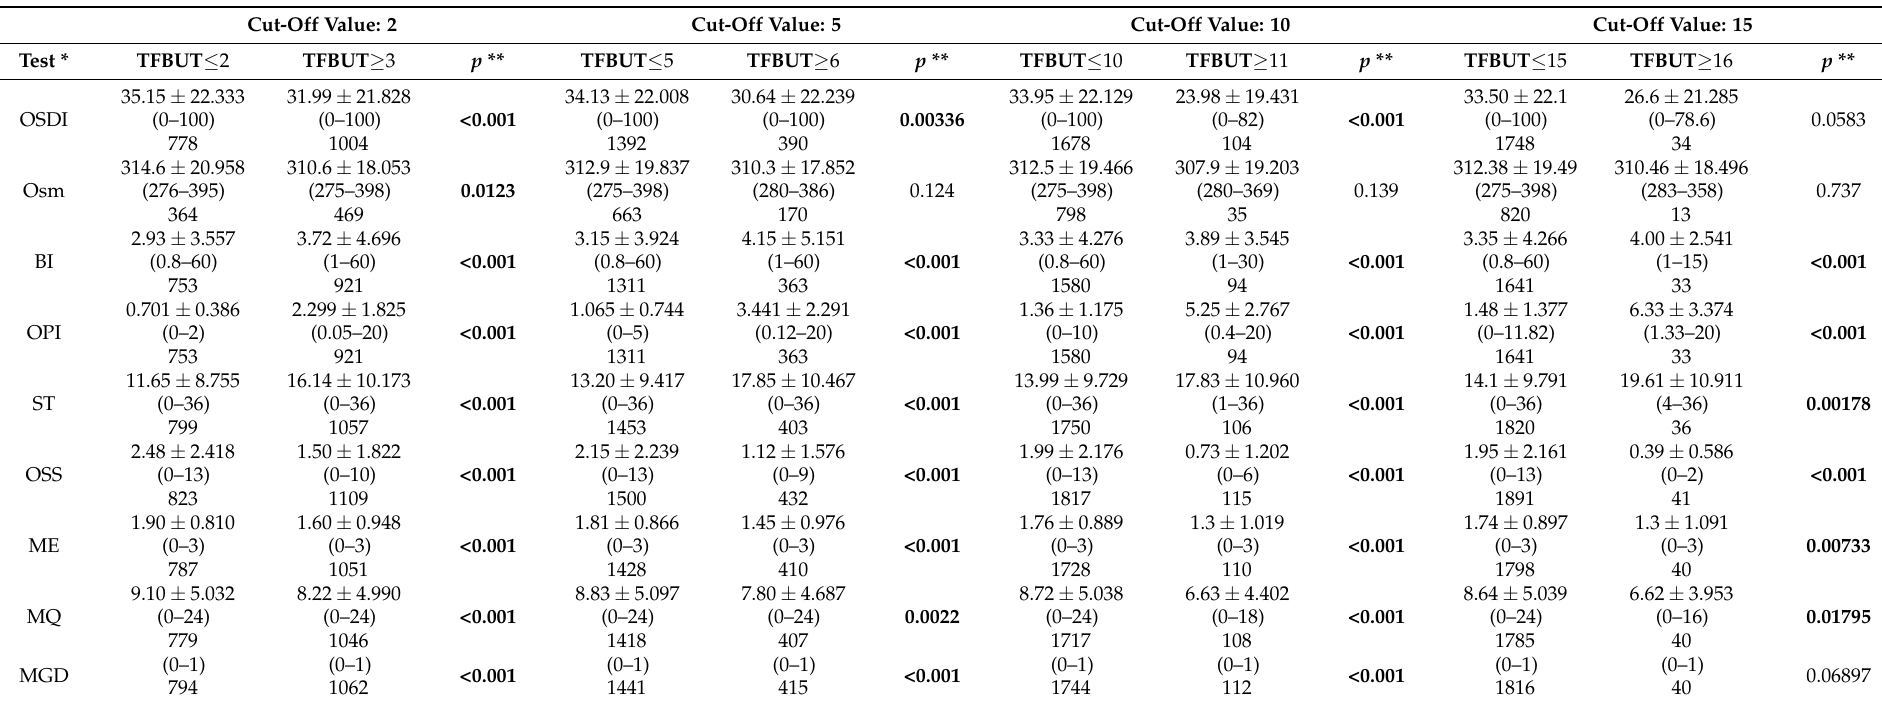
Table 4. Comparison of clinical parameter results between groups based on the four defined cut-off values (2, 5, 10, and 15) for pathological dry eye disease (DED) measured by TFBUT (mean ± standard deviation, range and sample size; p -value of Mann–Whitney test of comparison for continuous variables and Chi-Square test for dichotomous one—meibomian gland dysfunction